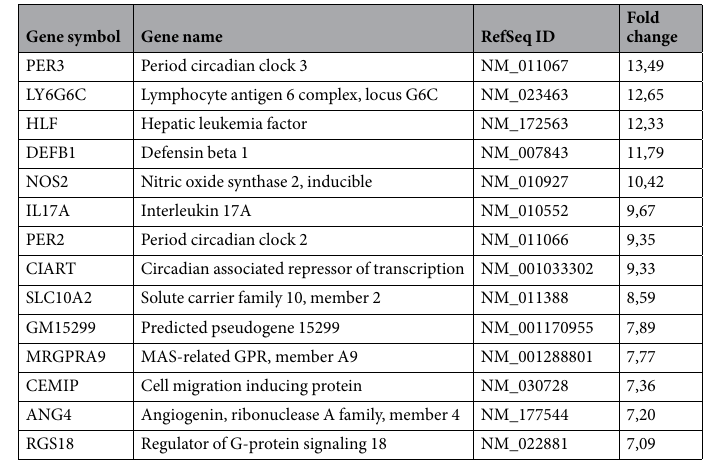
Table 1. Top 15 most upregulated genes as identified by RNA-seq in C57BL/6 WT infected mice versus C57BL/6 WT uninfected control